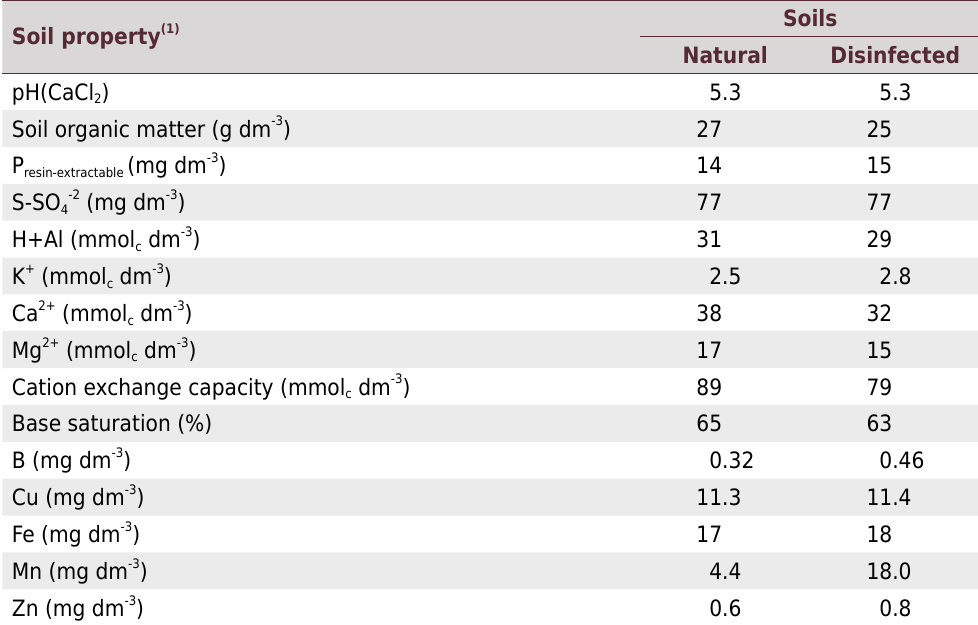
Table 1. Soil chemical properties of natural and disinfected soils before cassava planting Soil property